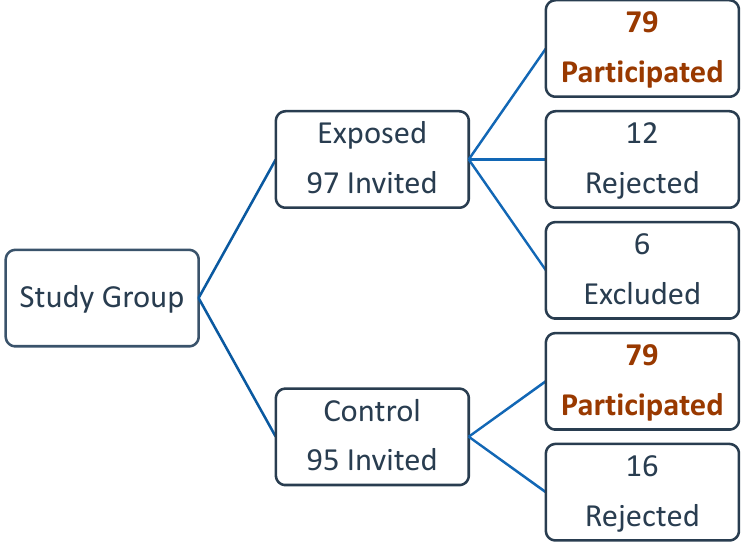
Figure 1. Study population and Sample.